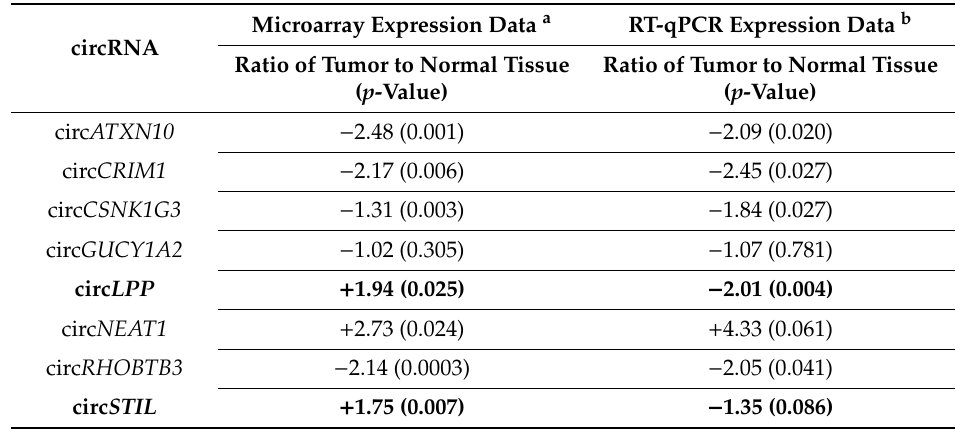
Table 4. Comparison of the circRNA expression data of the six paired tumor and adjacent normal tissue samples used in the microarray and RT-qPCR